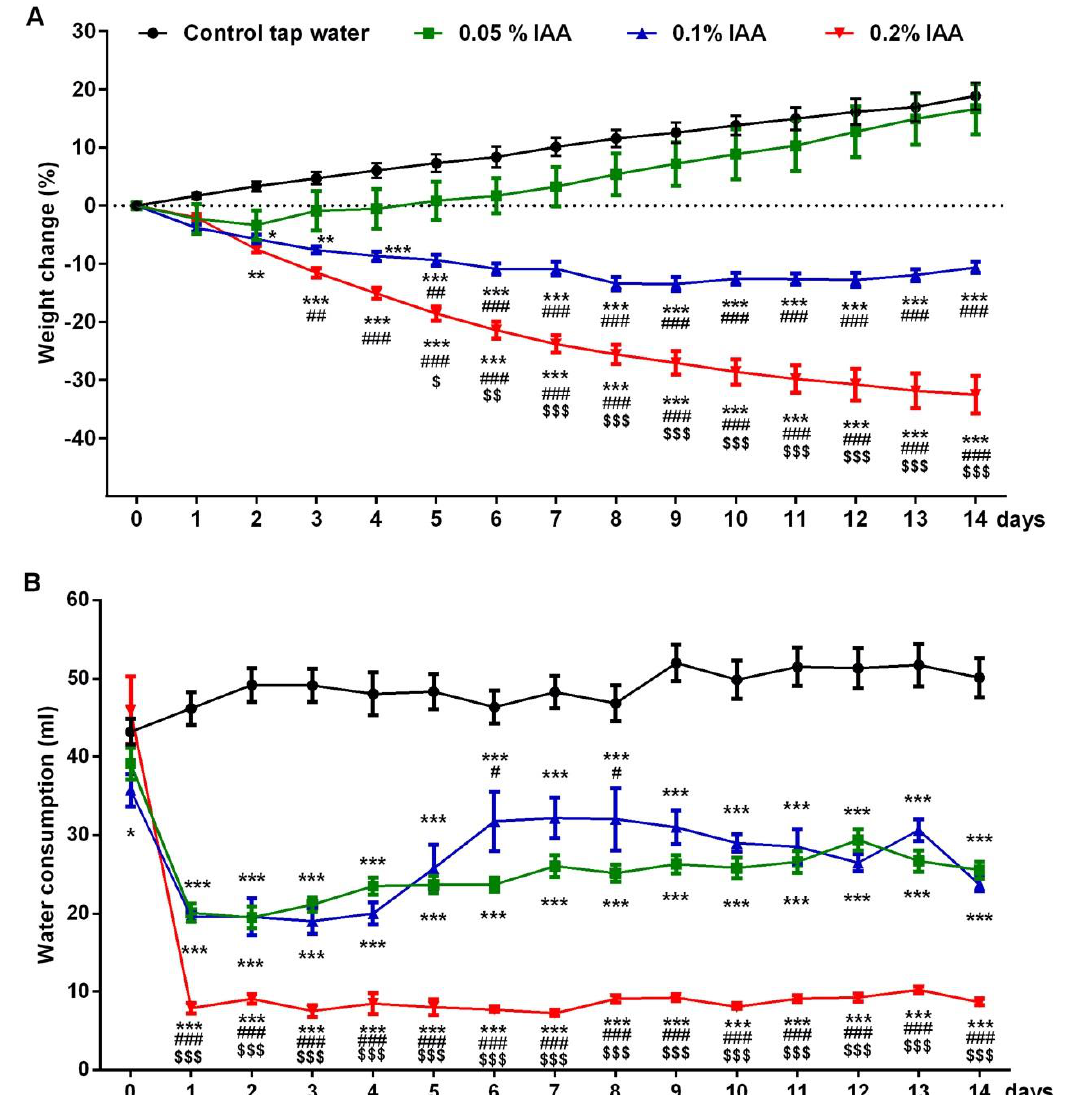
Figure 4. IAA-induced body weight change and water intake in Wistar rats. ( A ) IAA administration resulted in a dose-dependent weight loss and ( B ) reduced water intake in Wistar rats. Data are shown as means ± SEM; n = 6 / group (repeated measures two-way ANOVA followed by Bonferroni’s